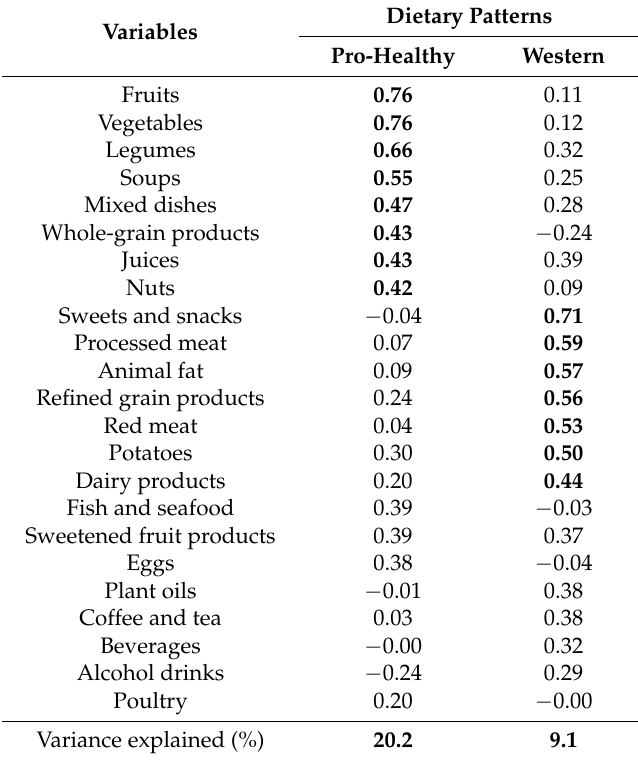
Table 2. Factor loadings of identified dietary